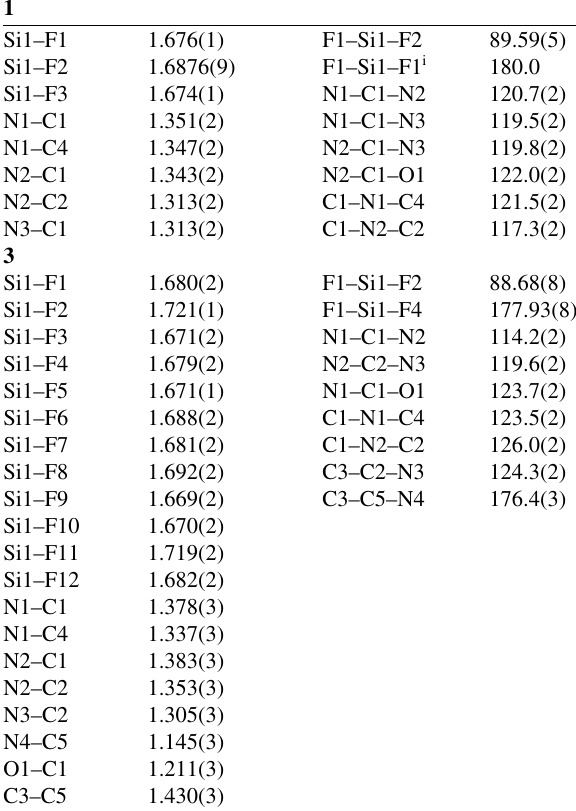
Table 2. Selected bond lengths (Å) and angles (°) for 1 and 3